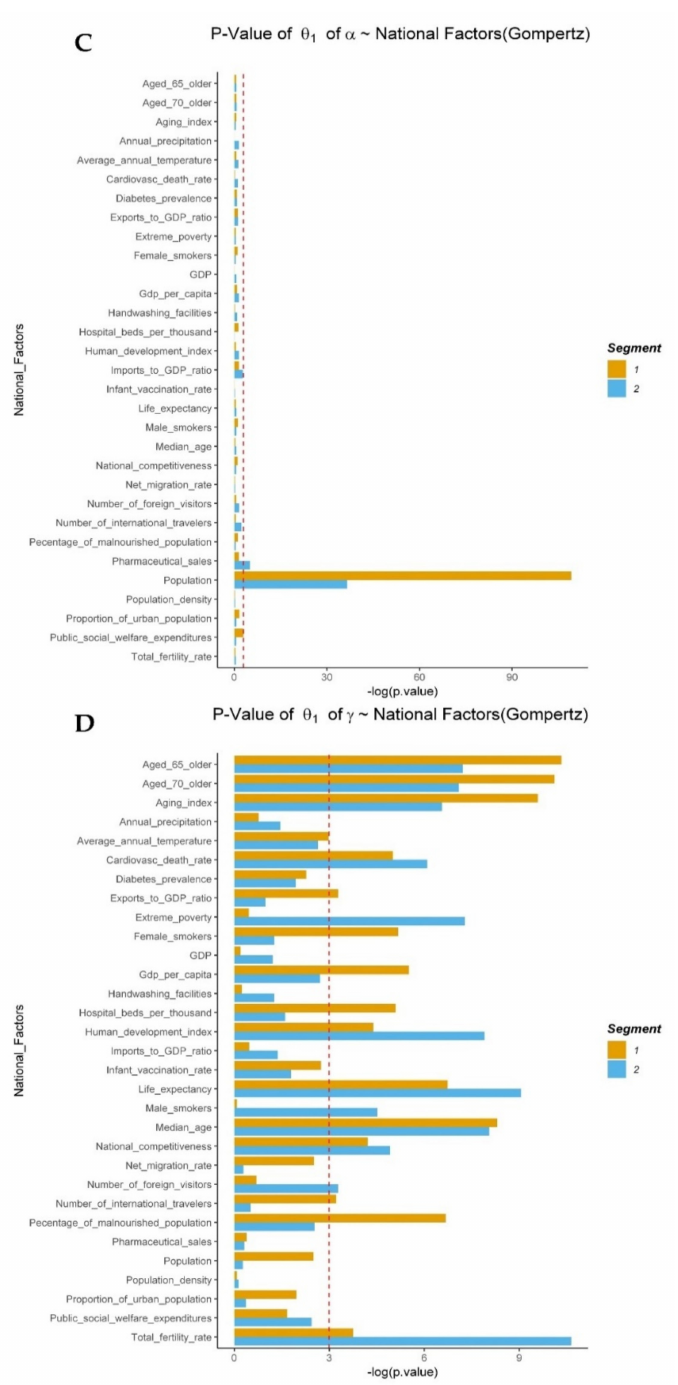
Figure 5. p -values of coefficients of national factors with α and γ . Population, annual precipitation, pharmaceutical sales, and imports to GDP ratio were statistically significant with α , the number of maximum predicted confirmed cases ( A , C ). Age-related factors, population, percentage of malnour- ished population, life expectancy, temperature, etc. were significantly related with γ , rate of spread of COVID-19 ( B , D ) (see Figure S8 for the relationship of national factors with β